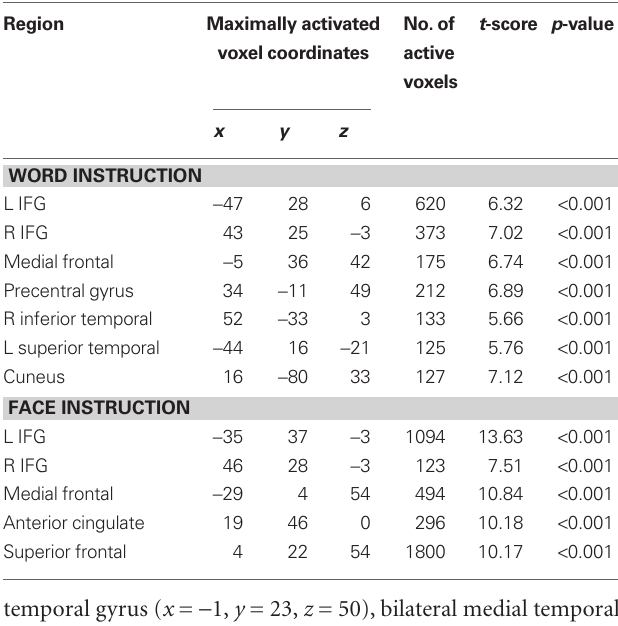
Table 1 | Regions of significant activation resulting from Incongruent blocks compared with Congruent blocks in the expression and Word instruction conditions ( n = 10).